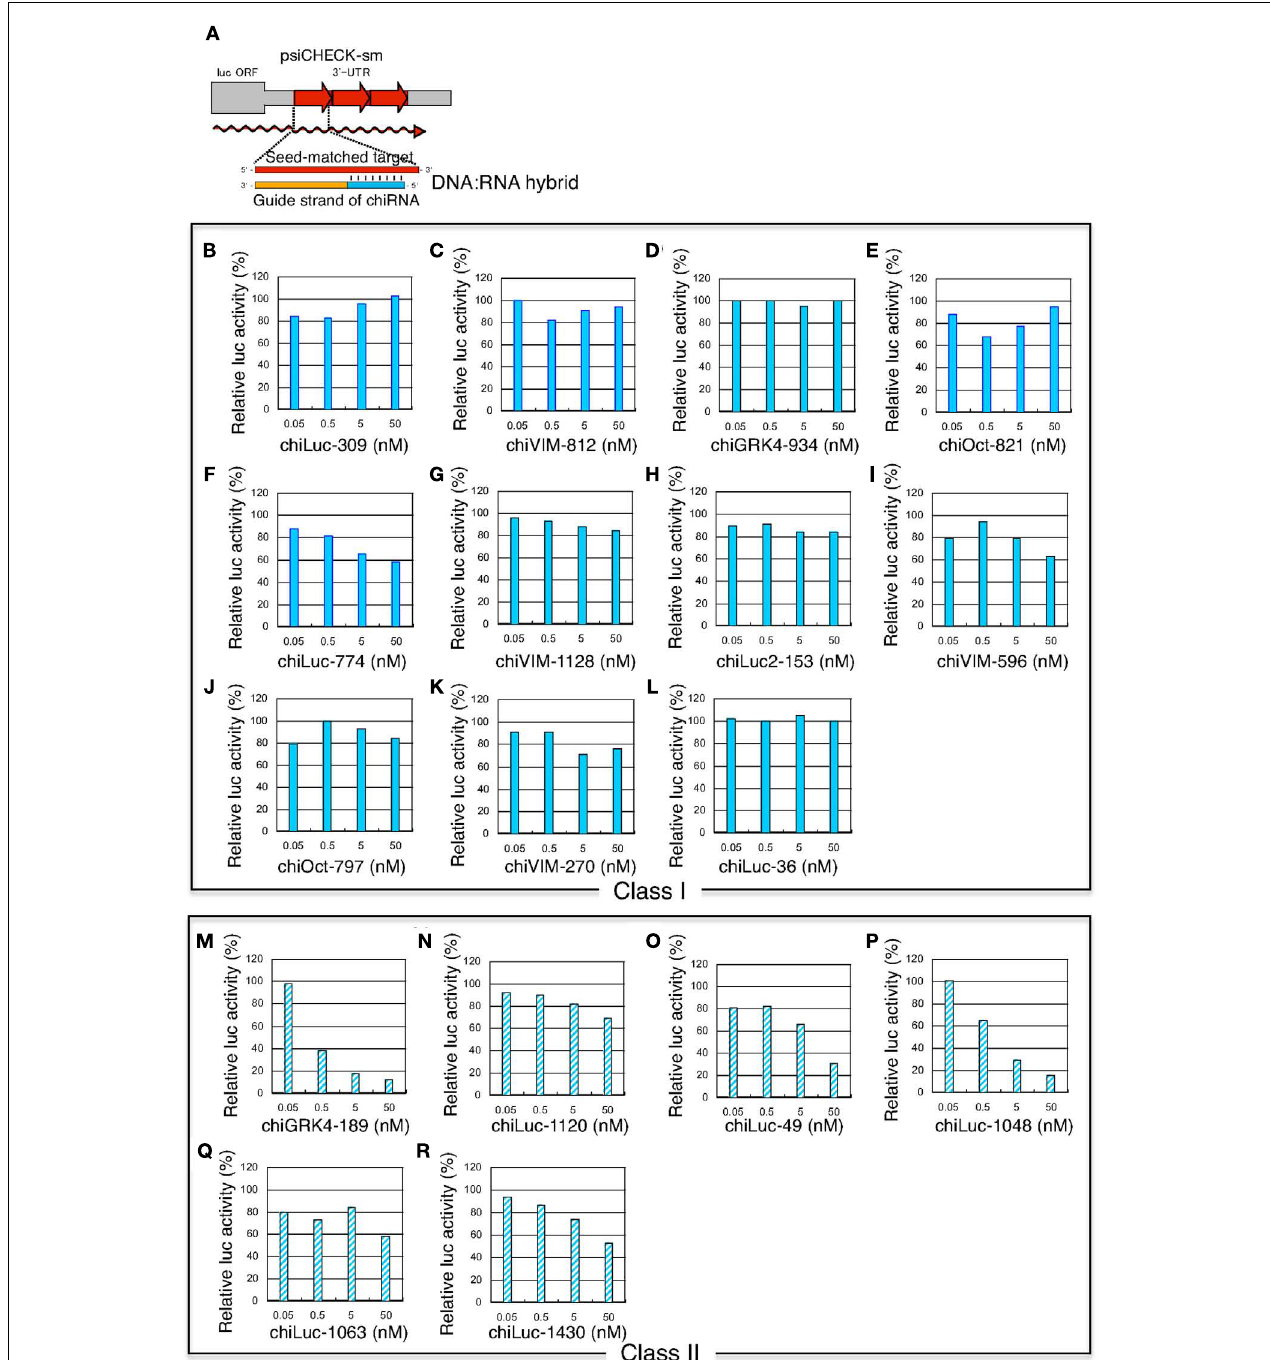
introduced into the region corresponding to the 3 (cid:2) UTR of the luciferase mRNA. In (B–R) , the effects of chiRNAs transfection on seed-matched targets are shown. (B–L) class I chiRNAs, (M–R) class II chiRNAs, (B) chiLuc-309, (C) chiVIM-812, (D) chiGRK4-934, (E) chiOct-821, (F) chiLuc-774, (G) chiVIM-1128, (H) chiLuc2-153, (I) chiVIM-596, (J) chiOct-797, (K) chiVIM-270, (L) chiLuc-36, (M) chiGRK4-189, (N) chiLuc-1120, (O) chiLuc-49, (P) chiLuc-1048, (Q) chiLuc-1063, (R) chiLuc-1430. chiRNA sequences and structures are shown in Figure 3B